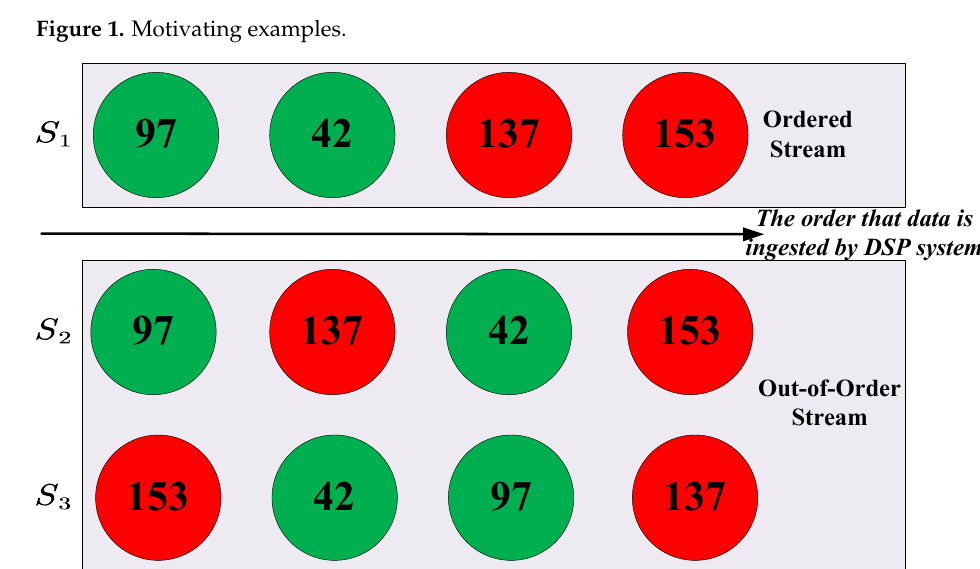
Figure 1. Motivating examples.